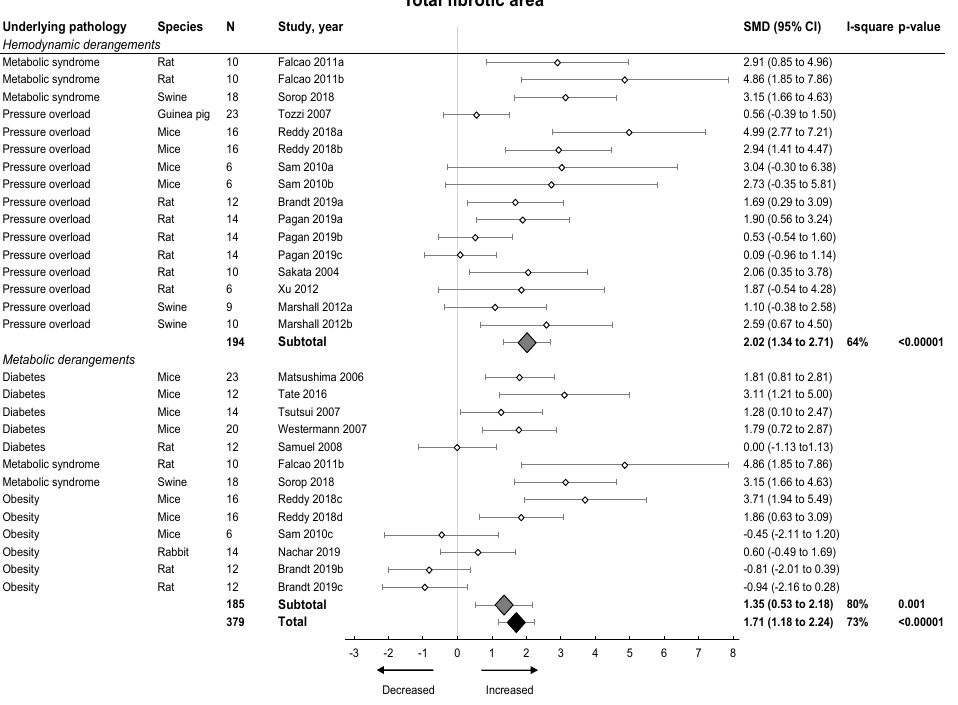
Figure 4. The e ff ect of LVDD / HFpEF on total fibrotic area. Forrest plot; the right side shows an increased e ff ect in LVDD / HFpEF animals, the left side shows a decreased e ff ect in LVDD / HFpEF animals. Data are presented as SMDs with 95% CI. Arrows indicate increased and decreased fibrotic percentage area respectively. Only the first author of each study is shown; multiple comparisons within one study are shown with a, b, c or d and correspond with the study overview (Table S1). CI, confidence interval; I 2 , measurement of heterogeneity; N, cumulative sample size; SMD, standardized mean difference.